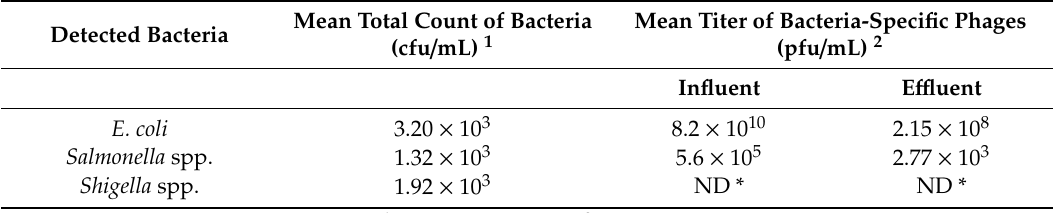
Table 3. Detection and quantification of indicator bacteria and their specific phages from Tubli WPCC wastewater.